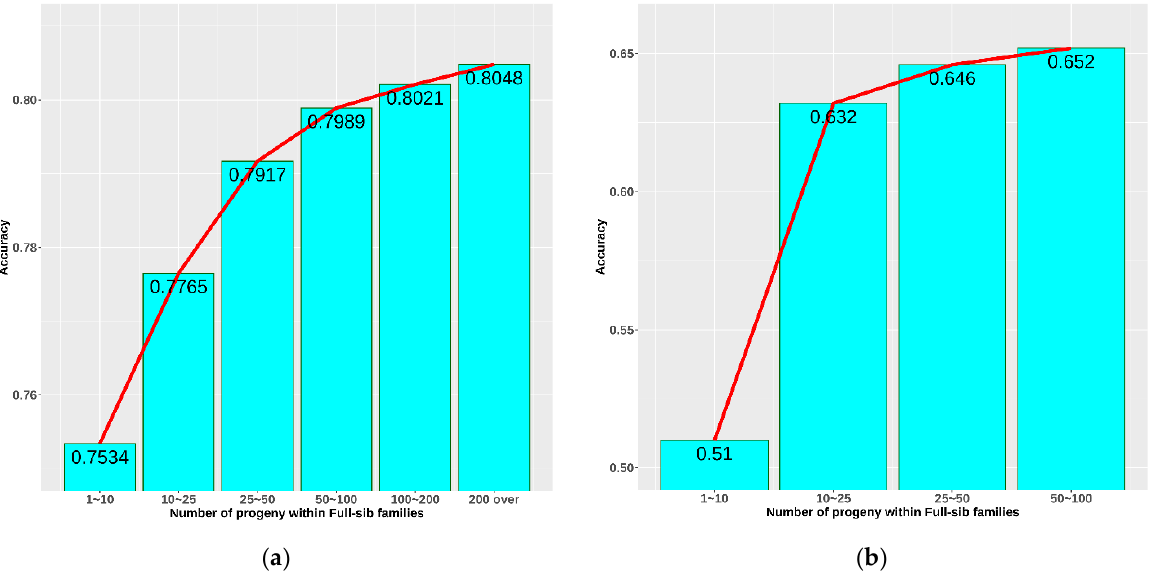
Figure 5. Accuracy as a function of the number of progeny within full-sib families: ( a ) accuracy of breeding value prediction from all information on 7 generations; ( b ) accuracy of parents’ breeding value prediction from 5 selected full-sib families in the 7th generation.